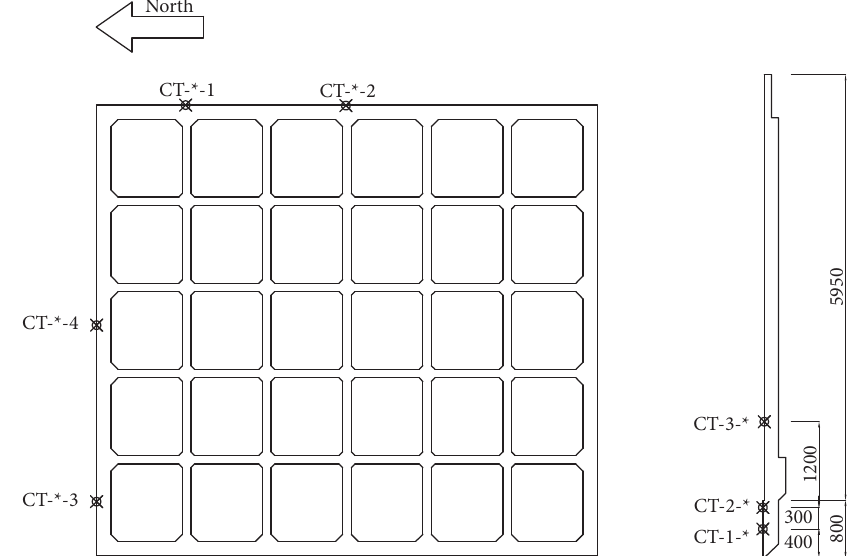
Figure 7: The location of soil pressure gauge on the sidewall (unit: